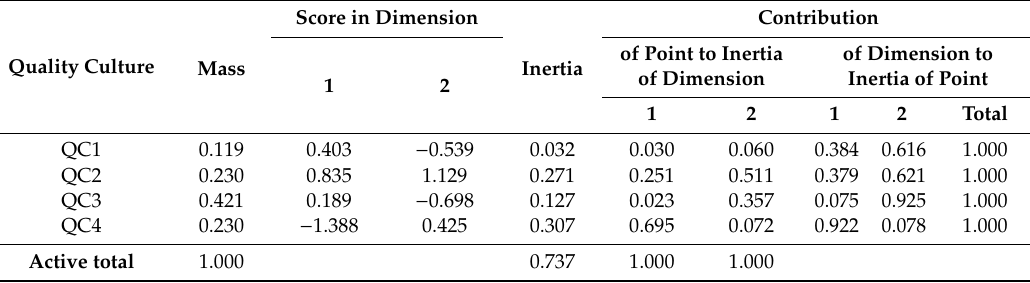
Table 6. Overview of column points.